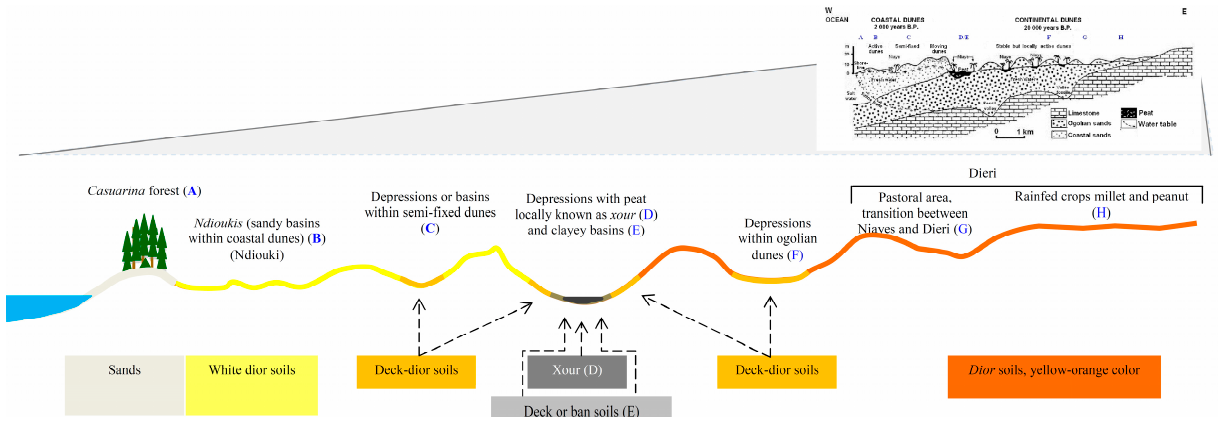
Figure 4. Diversity of depressions and soils, according to topography (and therefore proximity of the water table).